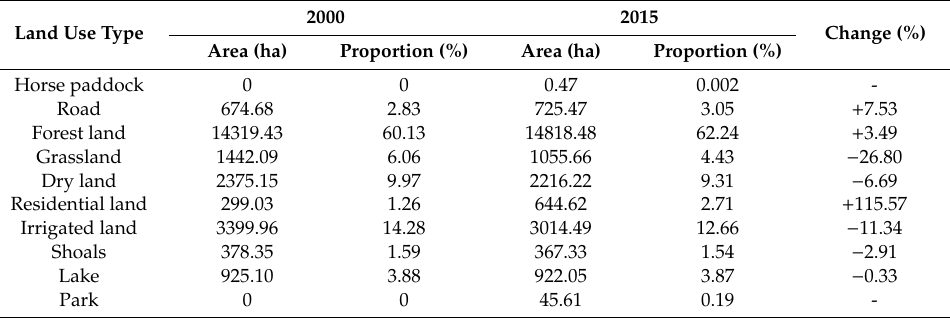
Table 7. Land use changes from 2000 to